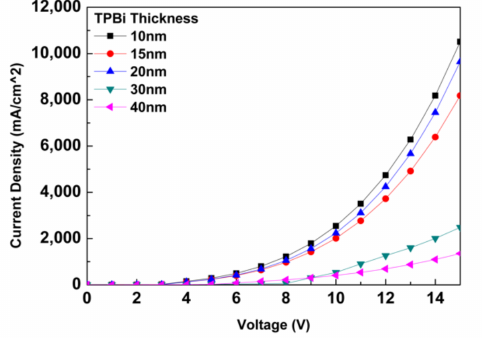
Figure 2. The current density and voltage curve diagram determined by the numerical calculation of the SCLC theoretical